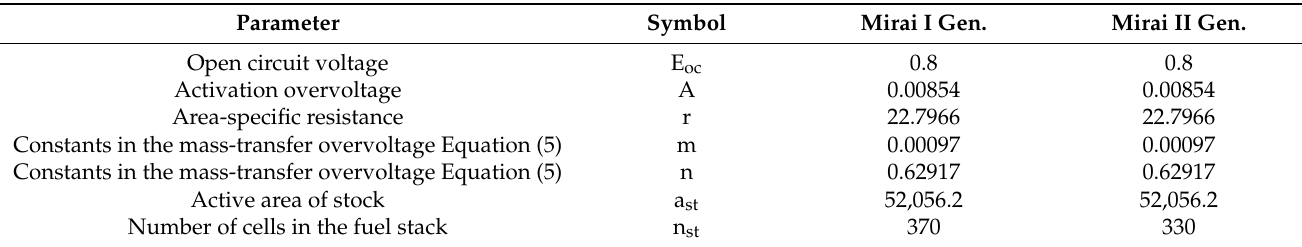
Table 3. Initial conditions for modeling fuel cells.